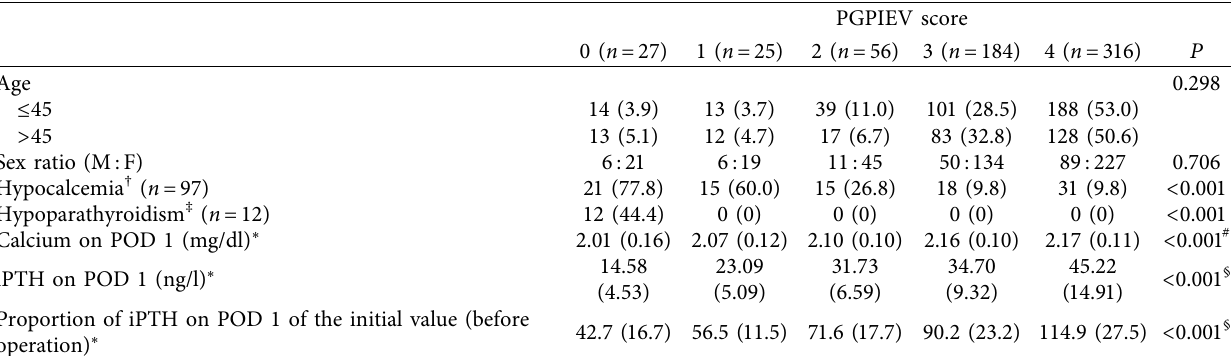
Table 3: Influence of parathyroid glands preserved in situ with excellent vascularity on the risk of hypocalcemia and hypoparathyroidism, and serum calcium and iPTH levels after total thyroidectomy plus central neck dissection.